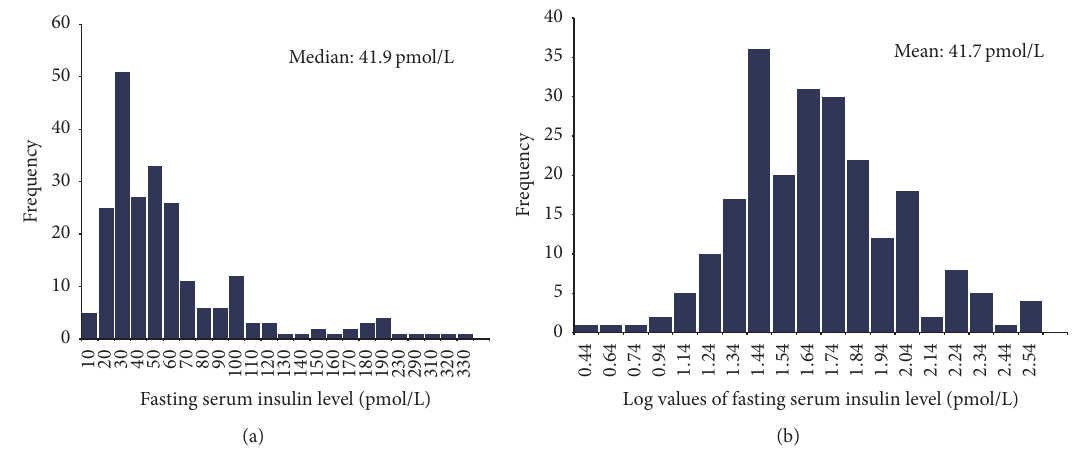
Figure 1: (a) Distribution of fasting serum insulin levels in the total study population ( 𝑛 = 227 ). (b) Distribution of natural log-scale of fasting serum insulin levels in the total study population ( 𝑛 = 227